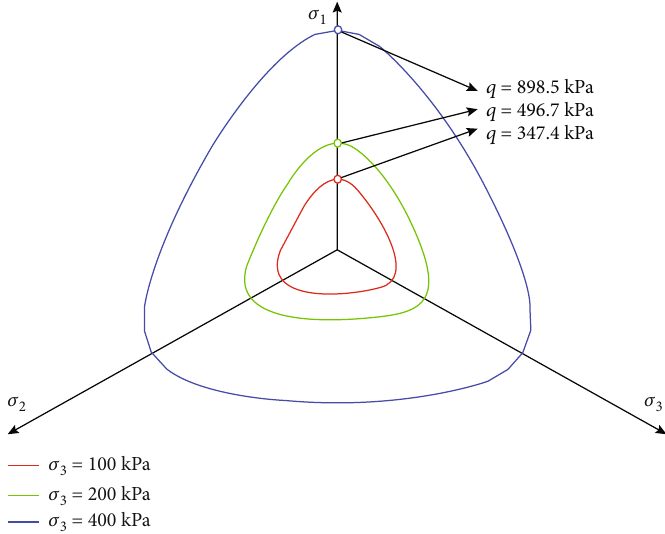
Figure 12: Yield curves of the silty clay under di ff erent con fi ning